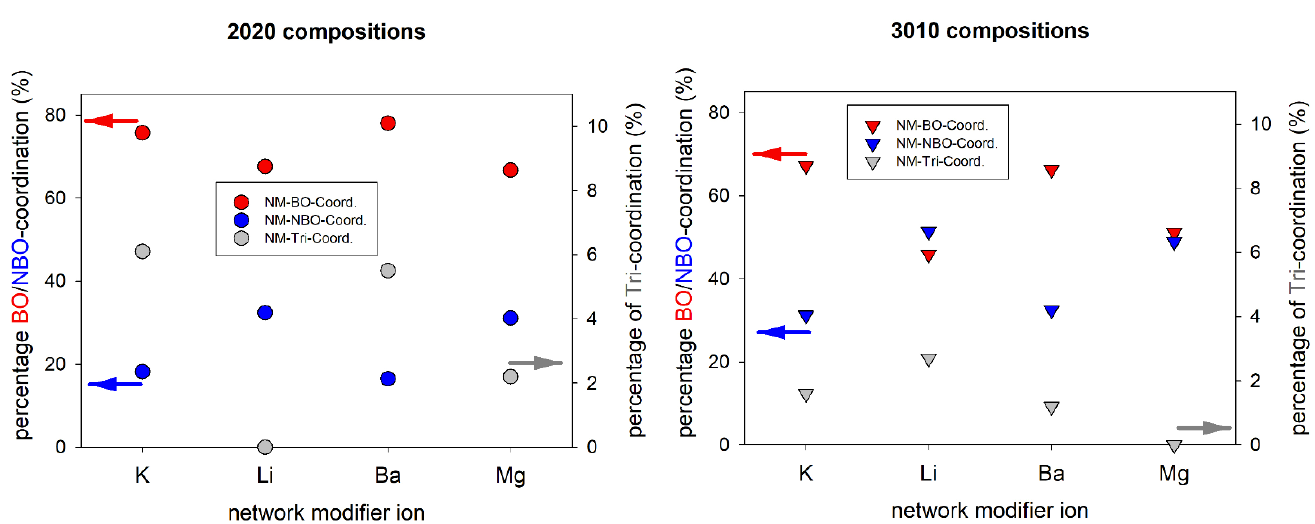
Figure 6. Network modifier-oxygen coordination fractions for metaluminous ( left ) and peralkaline ( right ) alkali and alkaline earth aluminosilicate glasses. Values for Ba and Mg-containing glasses are taken from [26].